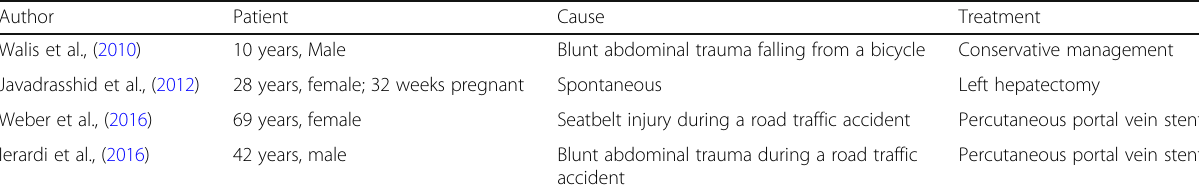
Table 1 Published cases of portal vein